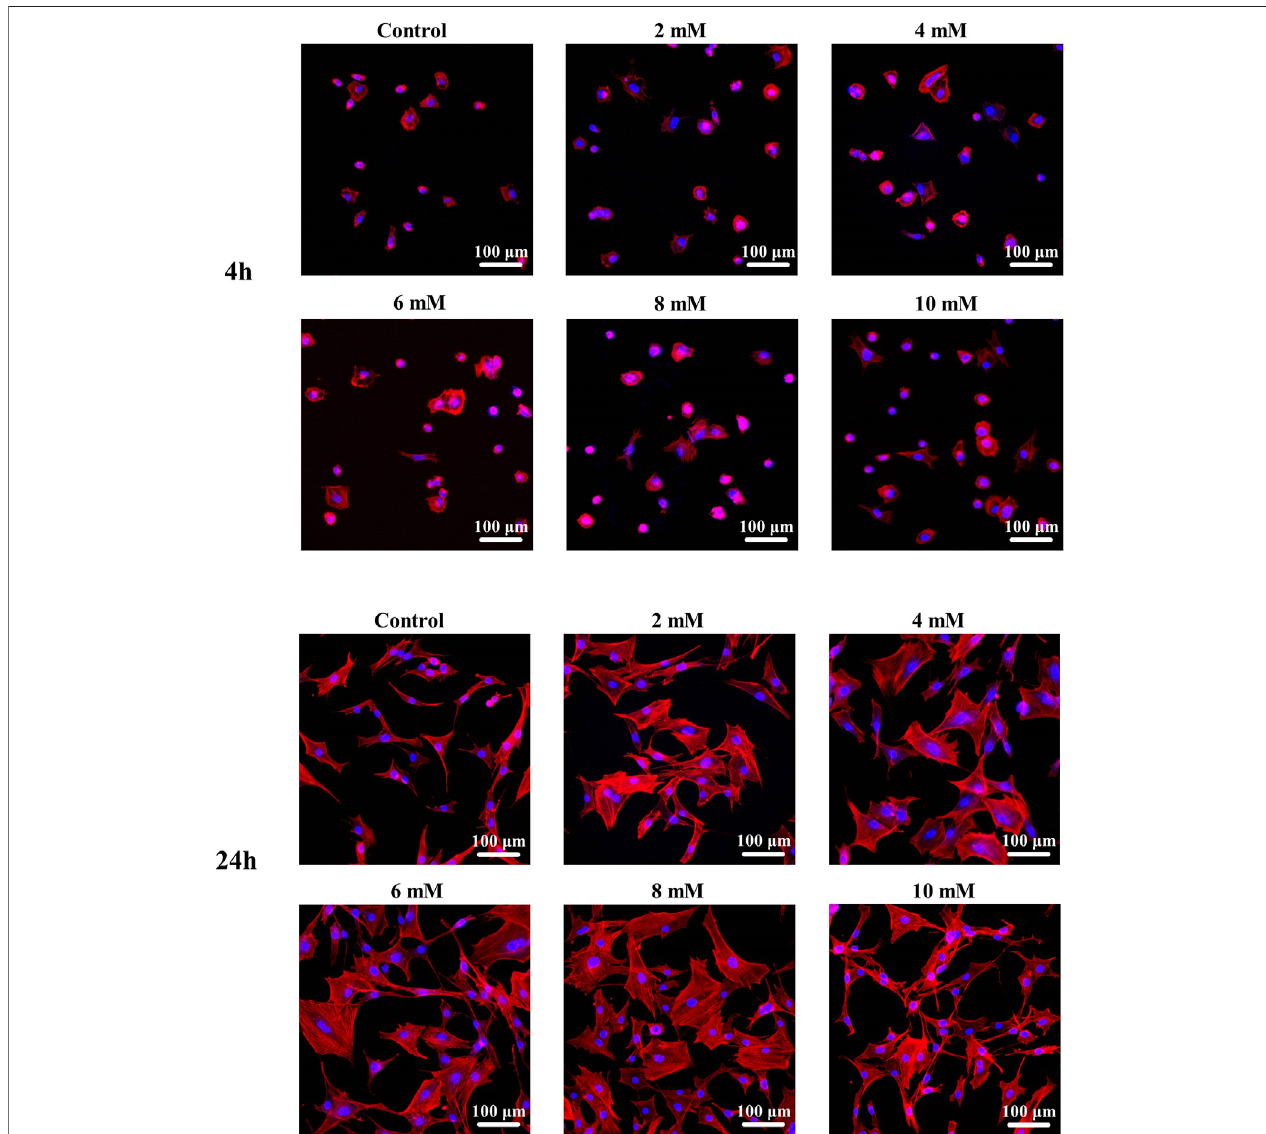
FIGURE 9 | Morphological staining of MC3T3-E1 cells cultured with gradient Mg 2+ concentrations for 4 and 24 h.